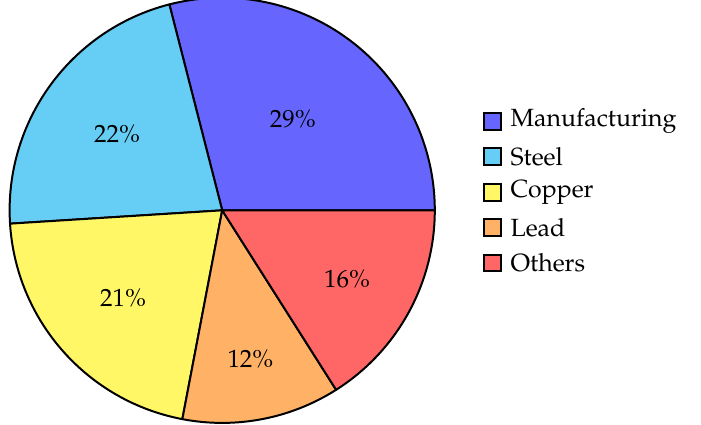
Figure A5. The contributions of the various components toward the emissions of the